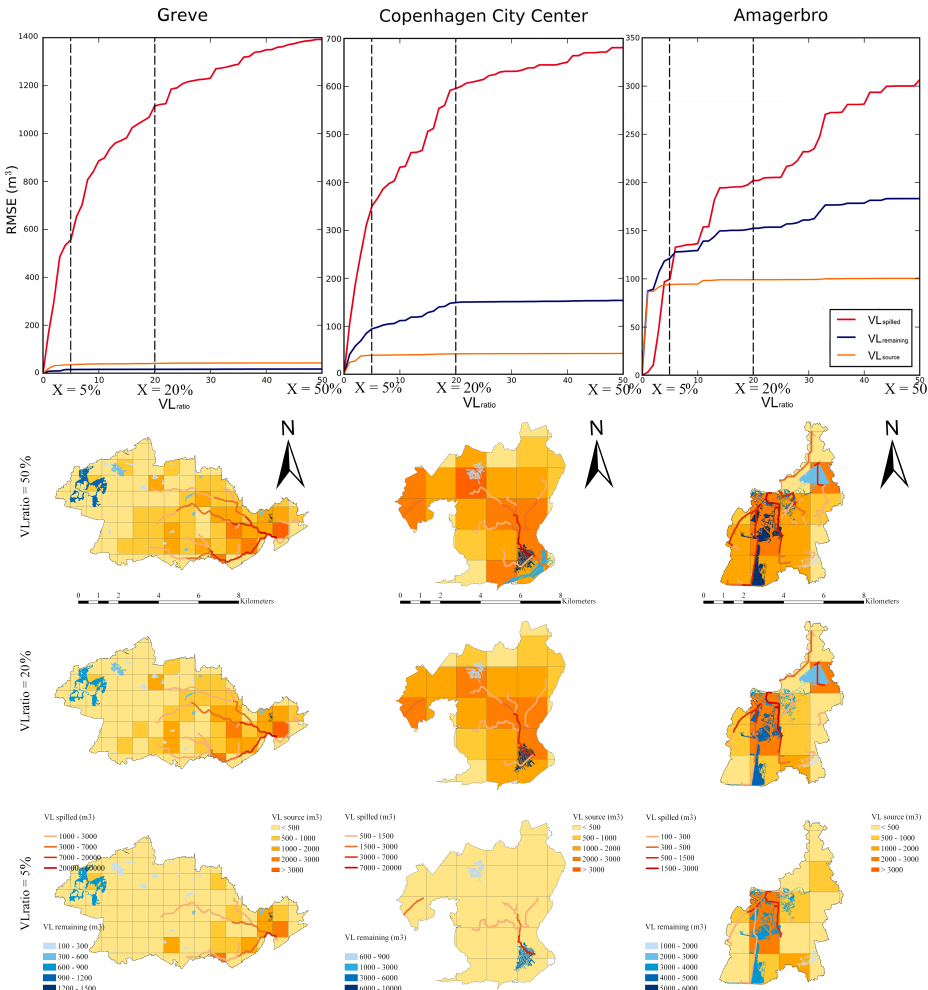
Figure 6. RMSE curves of volume losses and maps, where the general reduction in volume losses was demonstrated, and detailed spatial variations were presented from the perspective of spilled volume losses, remaining volume losses and source volume